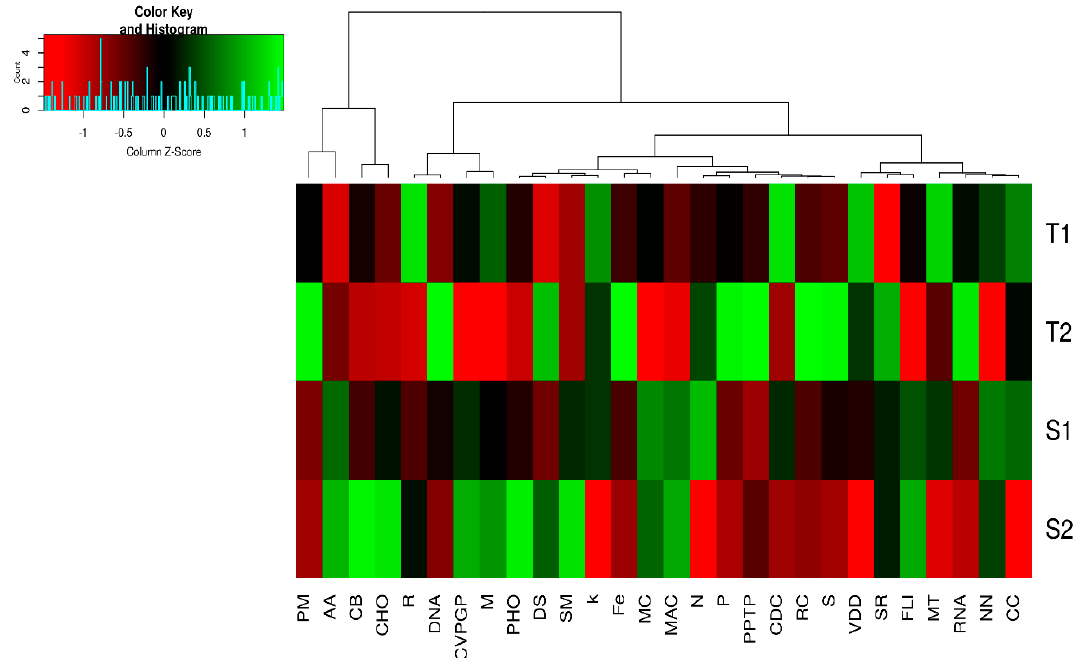
Figure 2. Sequences similar to major metabolisms in termite mound soils and the surrounding soil samples. The scale bar represents color saturation gradient based on the relative abundances with z-score transformed relative abundance of the functional gene categories. Abbreviations are as indicated in the text above.